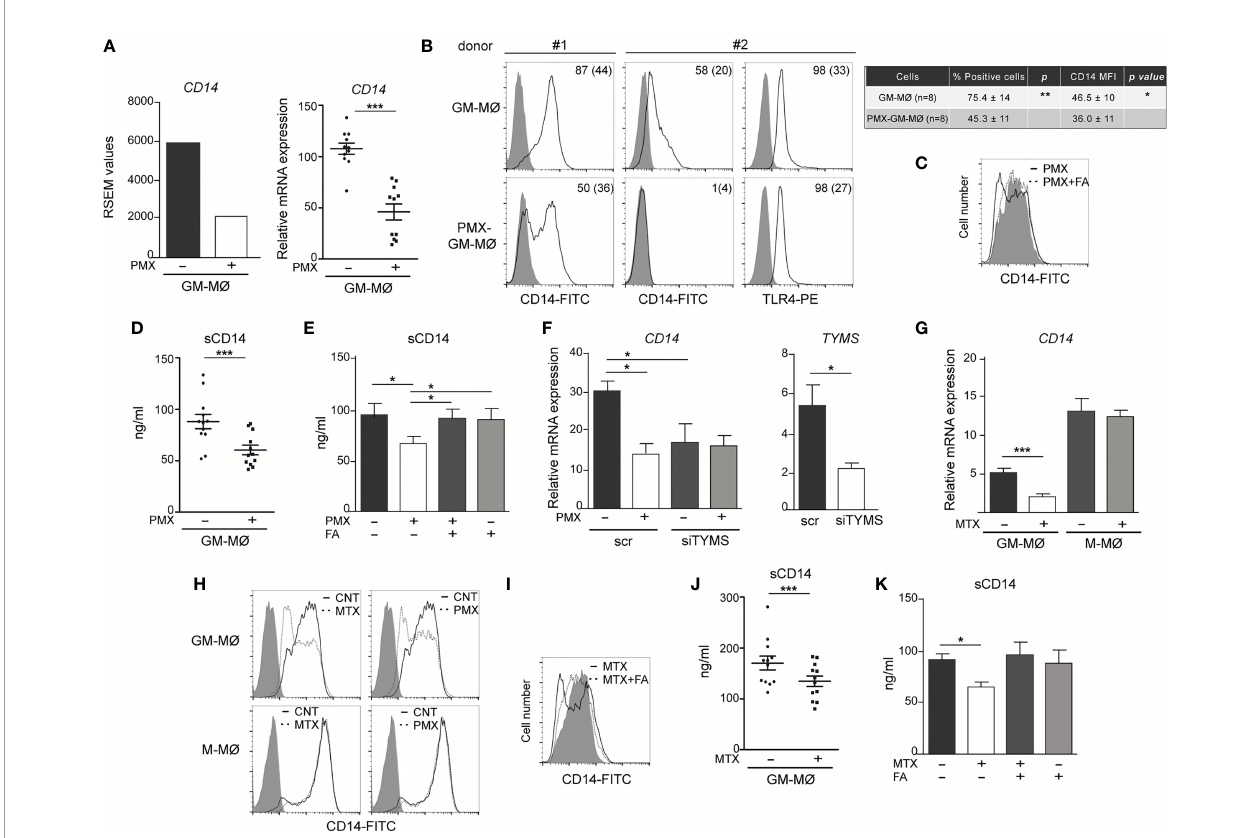
FIGURE 5 | OCM blockade diminished CD14 expression on GM-CSF-primed macrophages. (A) CD14 mRNA expression on monocytes stimulated with PMX during the GM-CSF-dependent differentiation process, as determined by RNAseq (adj p = 10 − 5 , left) and by qRT-PCR (right, n = 11 independent donors; each symbol represents a single donor, *** p < 0.001). (B) Cell surface expression of CD14 and TLR4 on monocytes differentiated with GM-CSF in the absence or in the presence of PMX, as determined by fl ow cytometry. Filled histograms indicate the fl uorescence levels produced by an isotype-matched antibody. The percentage of marker-positive cells and the mean fl uorescence intensity (in parentheses) are indicated. The experiment was done on eight independent donors, and two representative donors are shown. The average of percentage of positive cells and MFI ± SD for CD14 in GM-MØ and PMX-GM-MØ is shown in the right panel. Groups were compared by applying the t-test (* p < 0.05, ** p < 0.01). (C) Cell surface expression of CD14 on monocytes differentiated with GM-CSF in the absence ( fi lled histograms) or in the presence of PMX (empty histograms) or PMX+FA for 7 days (histograms with a dotted line), as determined by fl ow cytometry. The experiment was done on four independent donors, and a representative is shown. (D) Soluble CD14 level in the supernatant of monocytes differentiated with GM-CSF in the absence or in the presence of PMX for 7 days, as determined by ELISA (n = 12 independent donors; each symbol represent a single donor; *** p < 0.001). (E) Soluble CD14 level in the supernatant of monocytes differentiated with GM-CSF in the absence or presence of PMX, folinic acid (FA), or both, as determined by ELISA (n = 6 independent donors). Groups were compared by applying one-way ANOVA (with Tukey ’ s post-hoc test, * p < 0.05). (F) Left, CD14 mRNA expression on GM-MØ transfected with control siRNA (scr) and siRNA for thymidylate synthase (siTYMS) and exposed to PMX for 48 h, as determined by qRT-PCR (n = 4 independent donors). Groups were compared by applying one-way ANOVA (with Tukey ’ s post-hoc test, * p < 0.05). Right, TYMS mRNA expression on GM-MØ transfected with control siRNA and siRNA for TYMS for 48 h, as determined by qRT-PCR (n = 4 independent donors, * p < 0.05). (G) CD14 mRNA expression on monocytes stimulated with MTX (50 nM) during the GM-CSF or M-CSF-dependent differentiation process, as determined by qRT-PCR (n = 6 independent donors, *** p < 0.001). (H) Cell surface expression of CD14 on monocytes differentiated with GM-CSF (GM-MØ) or M-CSF (GM- MØ) in the absence (empty histograms) or in the presence of MTX or PMX (histograms with a dotted line), as determined by fl ow cytometry. Filled histograms indicate the fl uorescence levels produced by an isotype-matched antibody. (I) Cell surface expression of CD14 on monocytes differentiated with GM-CSF in the absence ( fi lled histograms) or in the presence of MTX (empty histograms) or MTX+FA (histograms with a dotted line), as determined by fl ow cytometry. For panels H and I, the experiment was done on four independent donors, and a representative is shown. (J) Soluble CD14 level in the supernatant of monocytes differentiated with GM-CSF in the absence or in the presence of MTX for 7 days, as determined by ELISA (n = 15 independent donors, each symbol represent a single donor; *** p < 0.001). (K) Soluble CD14 level in the supernatant of monocytes differentiated with GM-CSF in the absence or presence of MTX, folinic acid (FA), or both, as determined by ELISA (n = 4 independent donors). Groups were compared by applying one-way ANOVA (with Tukey ’ s post-hoc test, * p <